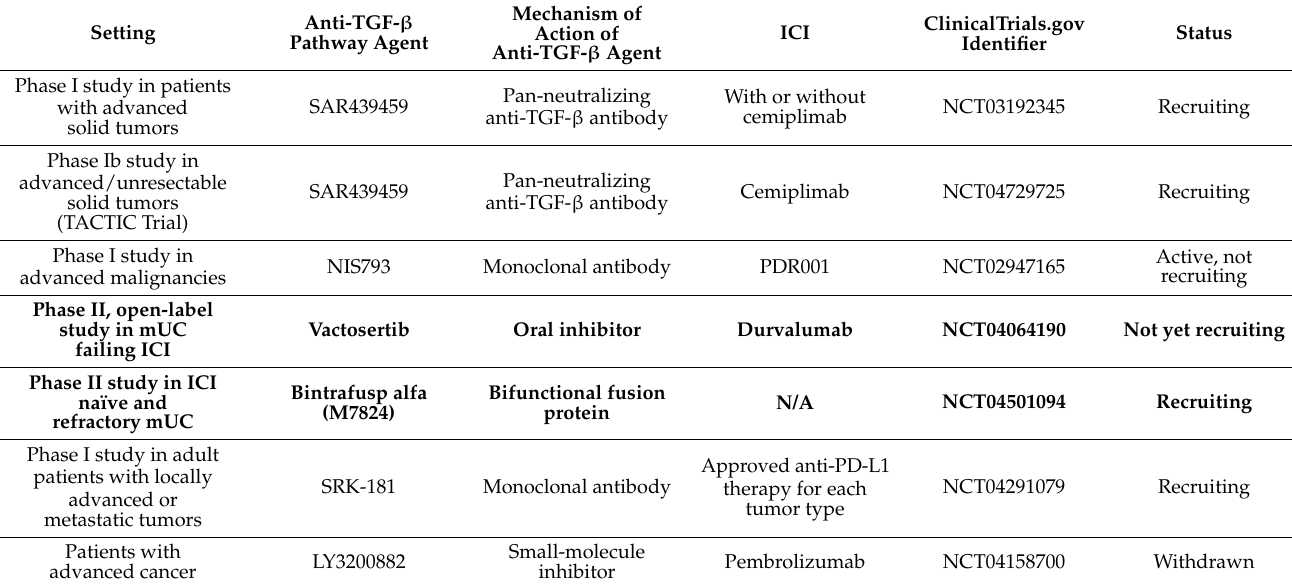
Table 2. Ongoing (highlighted in bold) and future clinical trials involving anti-TGF- β pathway therapies with or without ICI in the setting of advanced/metastatic UC or advanced solid